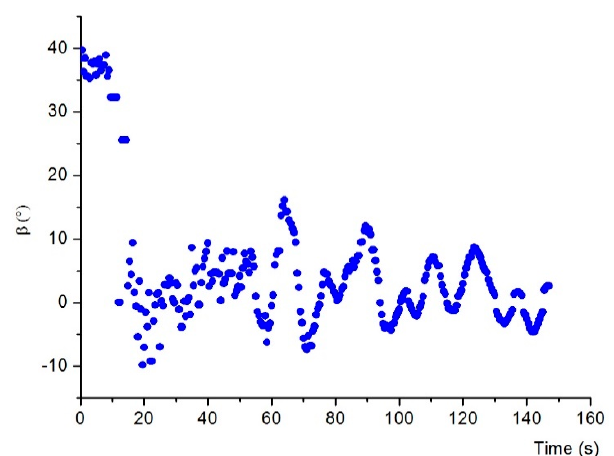
Figure 20. Deflection angle measured by the magnetic sensor during docking in normal position.